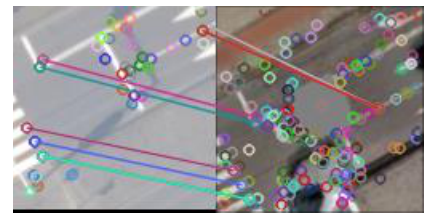
Figure 12 Matched SIFT keypoints in the second scene and second iteration